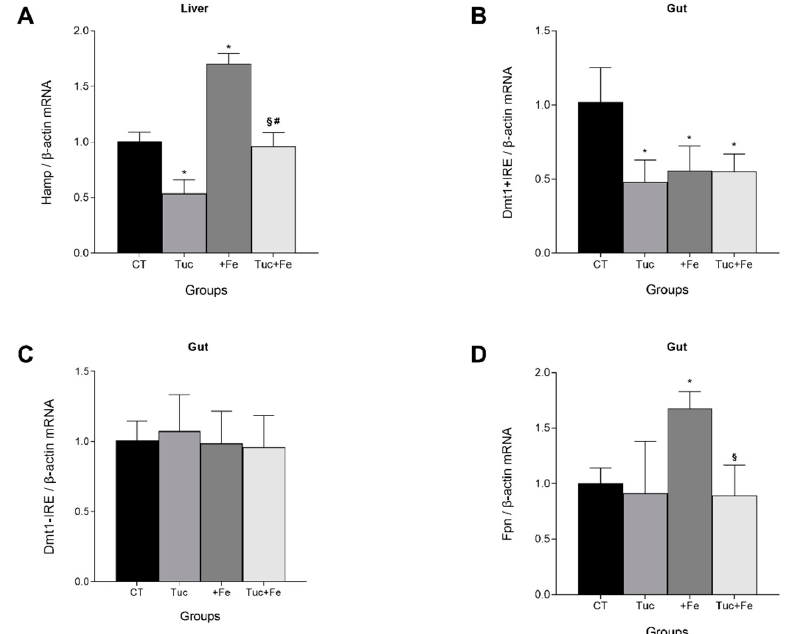
Figure 1. mRNA level quantification in rats fed control diet, tucum-do-cerrado (Tuc), iron-enriched diet ( + Fe), or tucum-do-cerrado iron-enriched diet (Tuc + Fe), for 12 weeks, of: hepatic hepcidin antimicrobial peptide (Hamp) ( A ); and gut divalent metal transporter 1 iron responsive element ( Dmt1 + IRE); ( B ) divalent metal transporter 1 non-iron responsive element ( Dmt1 -IRE); and ( C ) ferroportin ( Fpn ) ( D ). Data are the average ± standard deviation ( n = 6). Statistical di ff erences compared to: * CT group; # Tuc group and § + Fe group and ( p <